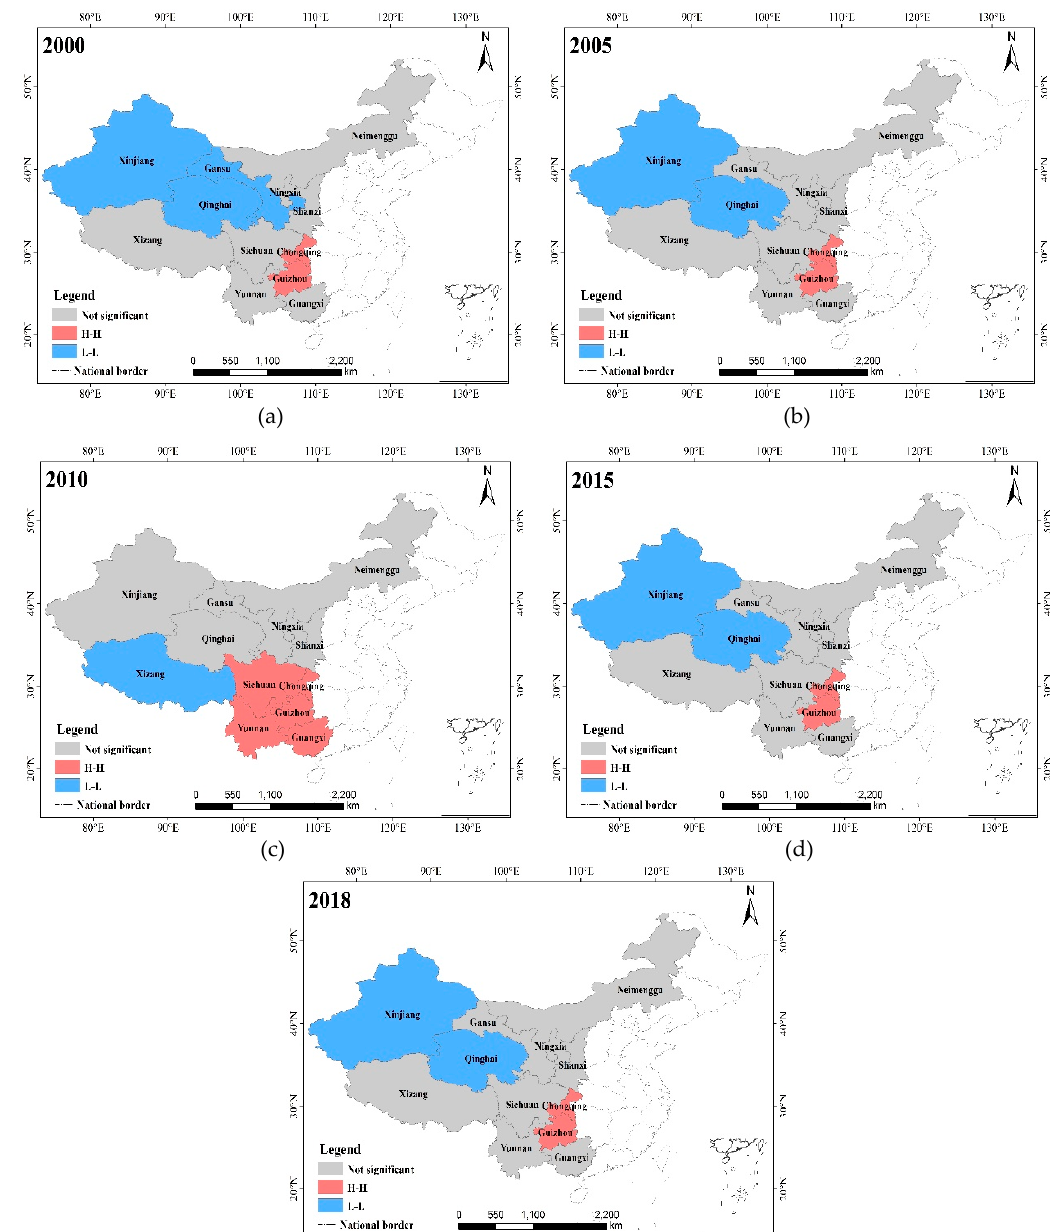
Figure 5. LISA cluster diagram of vegetation coverage for western China in 2000 (a), 2005 (b), 2010 (c), 2015 (d), 2018 (e). Low-Low (L-L); High-High (H-H).